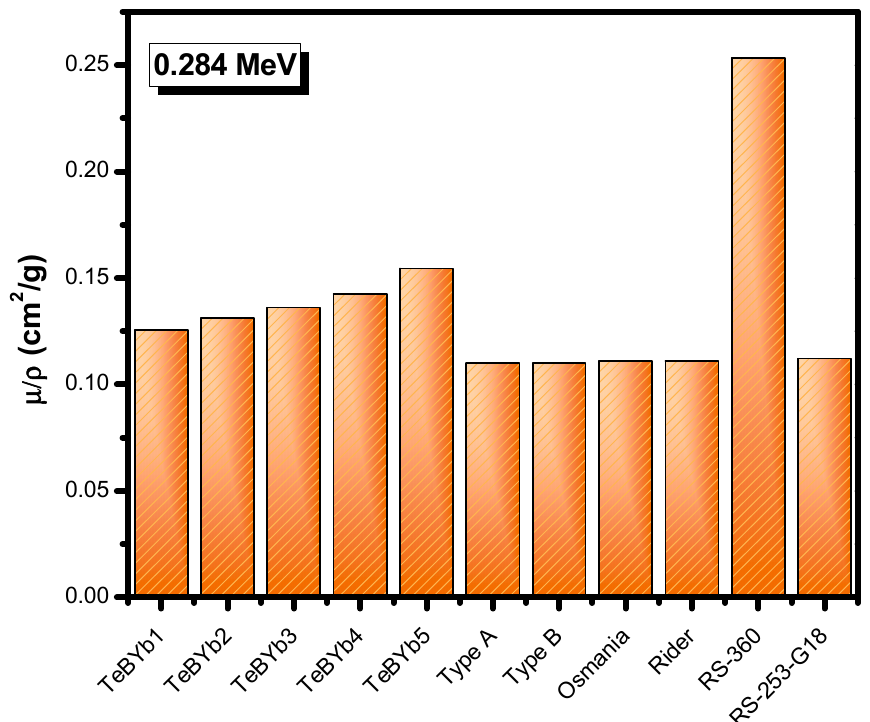
Figure 1. The mass attenuation coefficient (cm 2 /g) for the TeBYbX glasses.